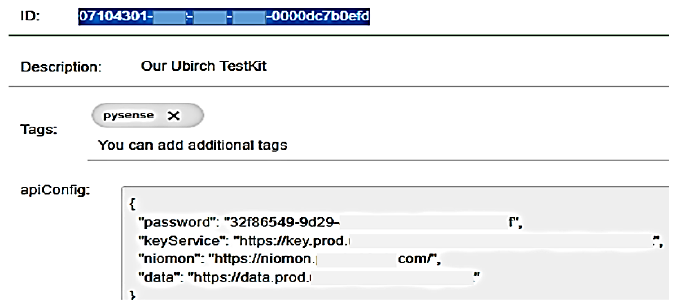
micro-SD card. Figure 27. UBIRCH Testkit hardware Components. 3.4.3. Initializing and Authentication of the Setup — Unlocking the SIM On initial startup, the Testkit will load the configuration from the SD card and con- nect to the NB-IoT network (APN: iot.1nce.net). So, to activate the SIM card, we make use of the UBIRCH backend [54] by claiming the card via registering its international mobile subscriber identity (IMSI). That is an internationally standardized 15-digit unique number